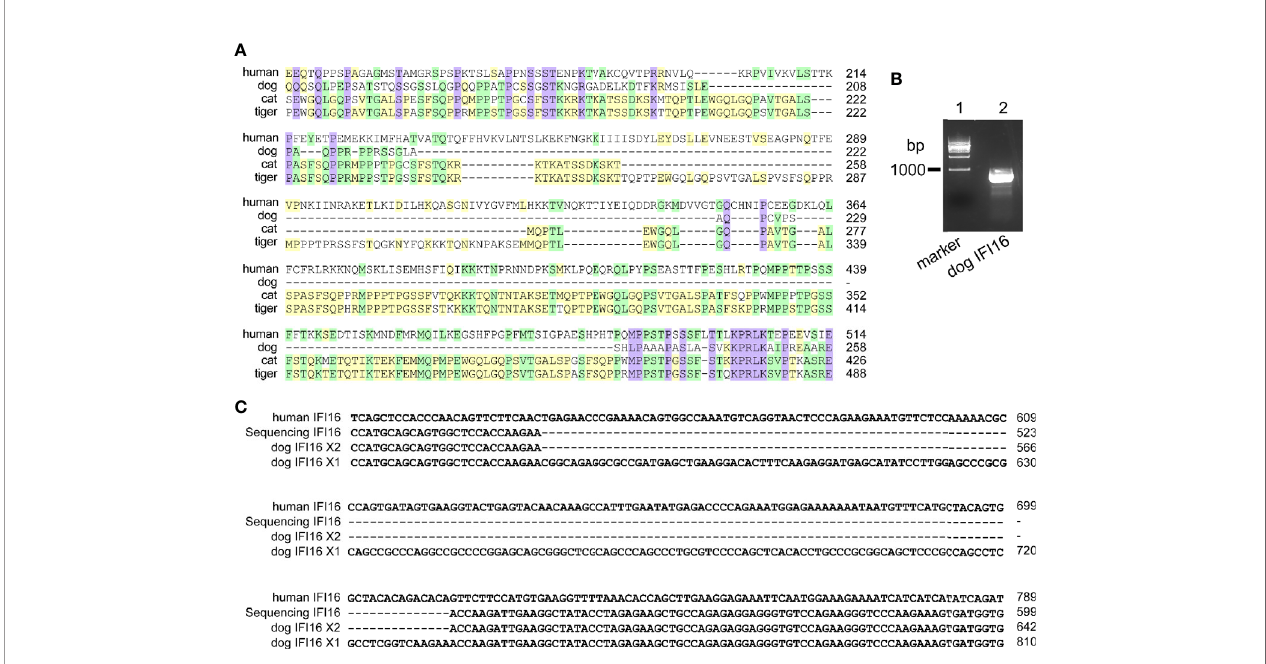
FIGURE 2 | IFI16 from dogs, cats, and tigers are shorter than human IFI16. (A) Partial sequence alignment of IFI16 from humans, dogs, cats and tigers. (B) PCR ampli fi cation of dog IFI16 from Madin-Darby canine kidney (MDCK) cell cDNA. Lane 1, marker of 1,000 bp ladder. Lane 2, band of dog IFI16. (C) Partial sequence alignment of PCR product sequence and dog IFI16 isoforms retrieved from annotated genome.